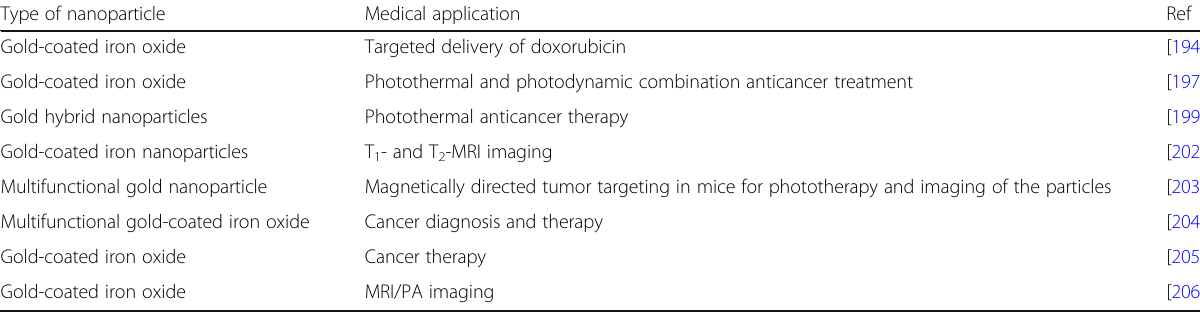
Table 6 Examples of the medical uses already been demonstrated for gold-coated iron magnetic nanoparticles